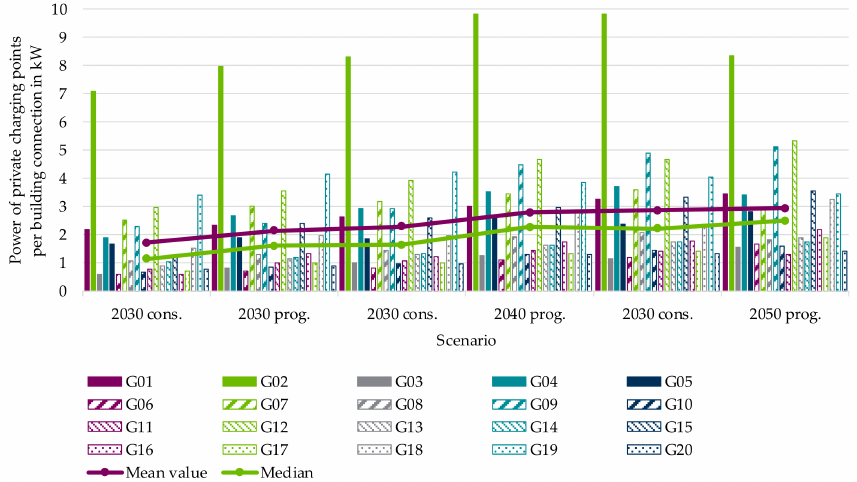
Figure 20. Average effective charging power of private charging points per building connection from the perspective of local distribution transformers for 20 low-voltage grids based on [41].